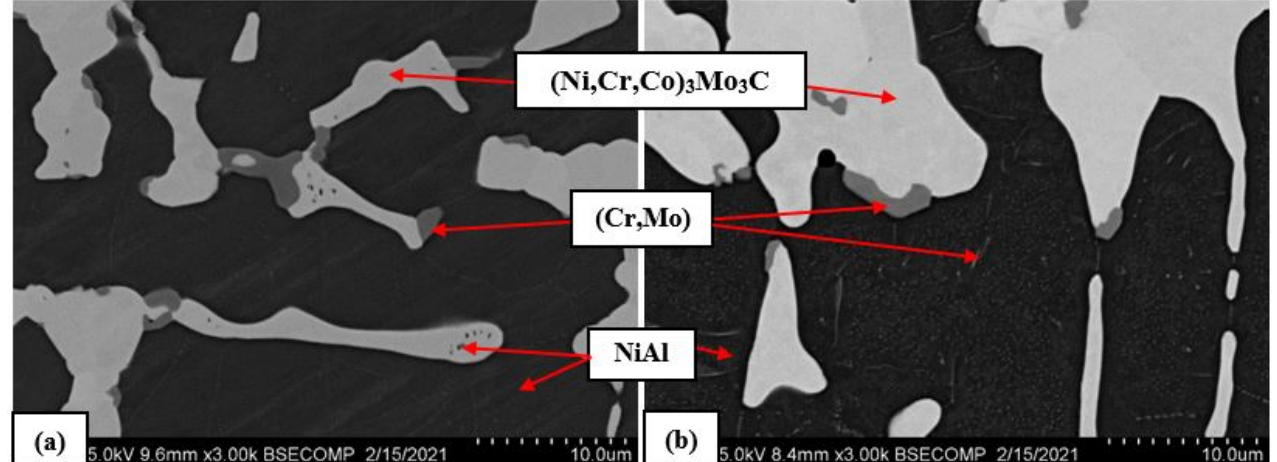
Figure 16. The microstructure of the NiAl–Cr–Co+15%Mo alloy after annealing at 1150 °C ( a ) and 1250 °C ( b ). Submicron-sized NiAl precipitates are observed after annealing 1150 °C (Figure 16a). No dispersed Cr(Mo) particles were detected within the bulk of NiAl grains. Contrariwise, precipitates of the (Cr,Mo) phase distributed both within the dendrite bodies and along the boundaries of NiAl grains can be seen after annealing at 1250 °C (Figure 16b). None of the two samples contained the Mo-based solid solution phase after the annealing.